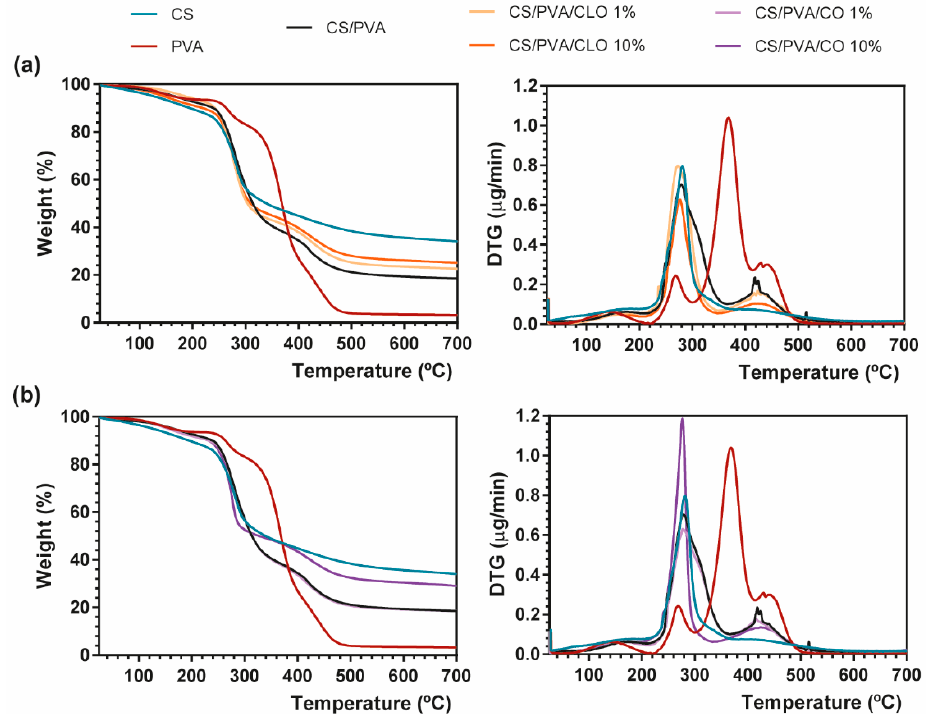
Figure 5. Representative TGA (left) and DTG (right) curves of ( a ) CLO- and ( b ) CO-loaded CS/PVA blended films, and respective controls from 25 to 700 °C, performed at a heating rate of 10 °C/min in a nitrogen atmosphere.